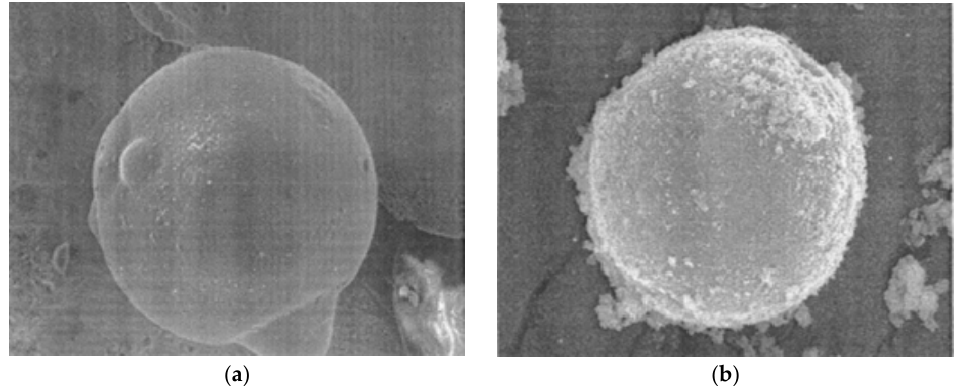
Figure 3. ( a ) SEM images of hollow glass microbeads; ( b ) SEM images of hollow glass microbeads wrapped with nano-TiO 2.